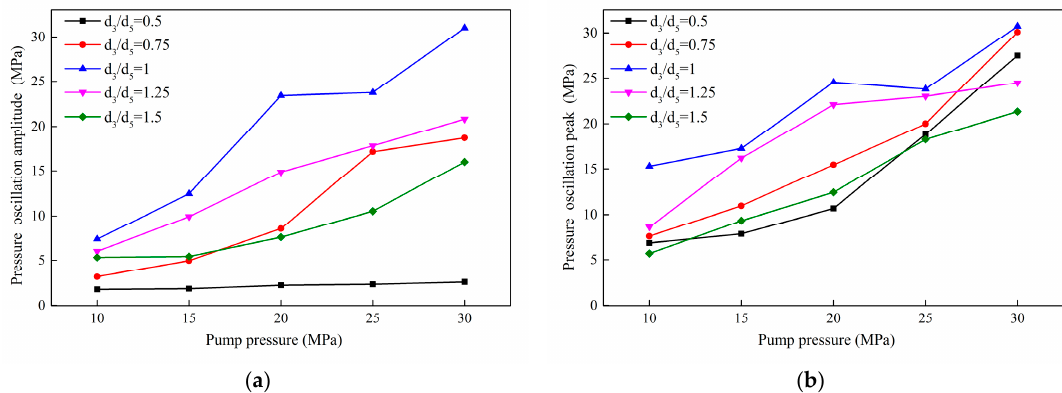
Figure 17. Performance of different d 3 / d 5 nozzles under each pump pressure. ( a ). maximal jet pressure pulsation amplitudes of different d 3 / d 5 nozzles. ( b ). maximal jet peak pressures of different d 3 / d 5 nozzles at each pump pressure.